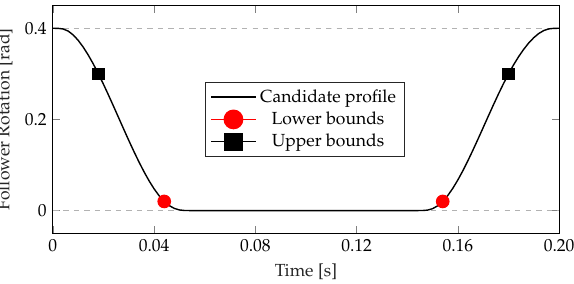
Figure 8. The four point constraints on the follower rotation ( θ follower ). Additionally, a candidate feasible trajectory is shown.